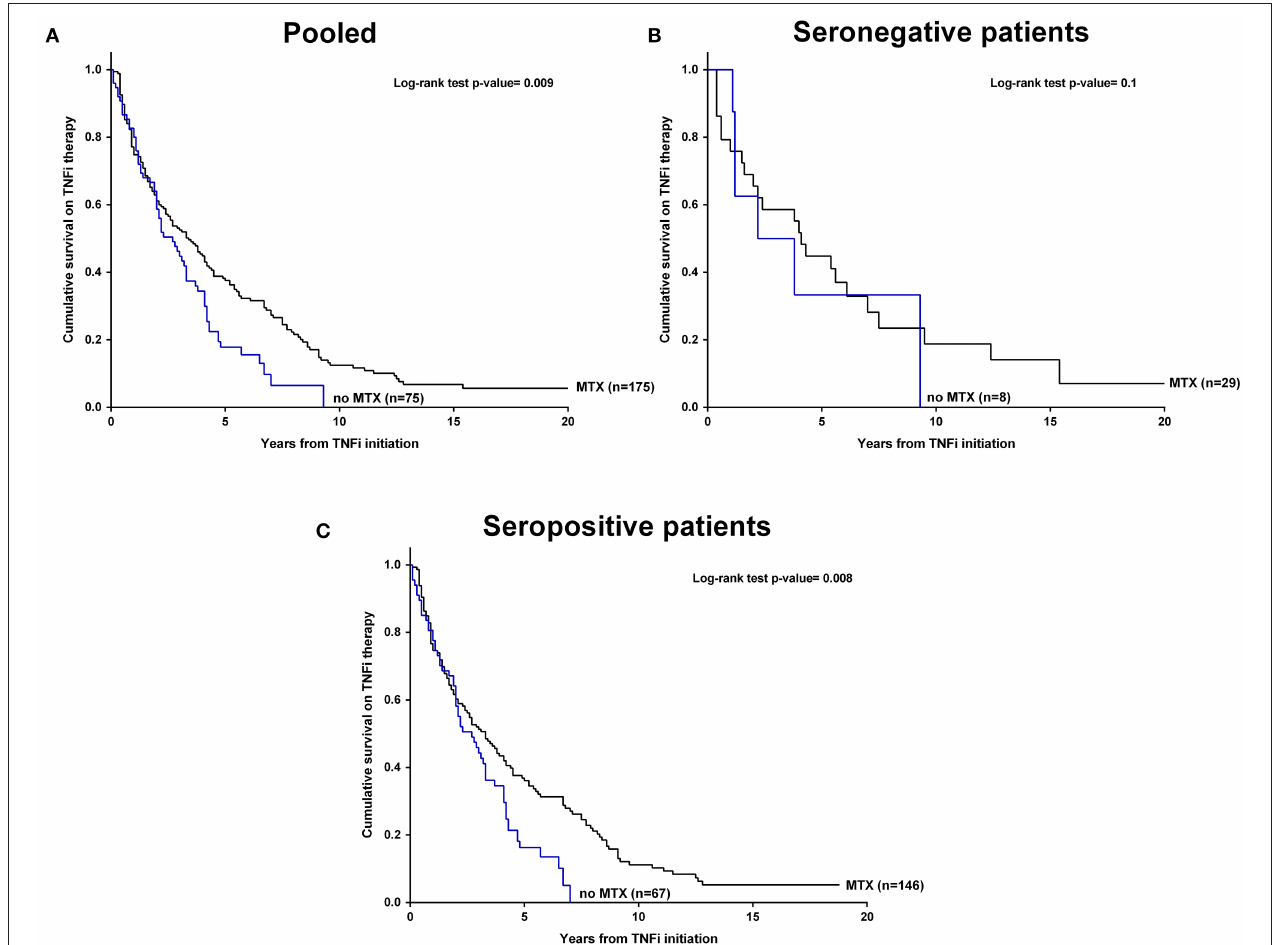
FIGURE 1 | Kaplan-Meier curves of cumulative survival on TNFi therapy by concomitant use of MTX in (A) cohort patients, (B) seronegative patients, and (C) seropositive patients. P < 0.05 was considered statistically significant. MTX, methotrexate; TNFi, tumor necrosis factor inhibitors.